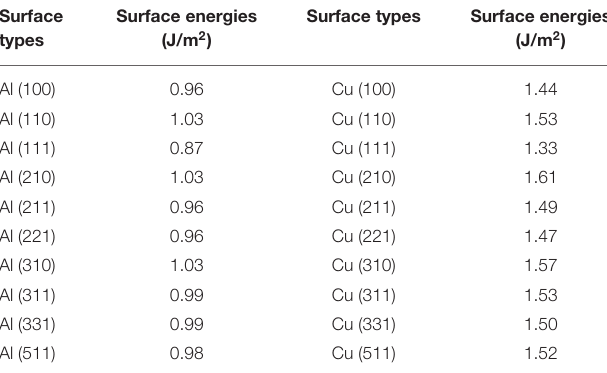
TABLE 1 | Theoretical values of the surface energies of various Al/Cu metal